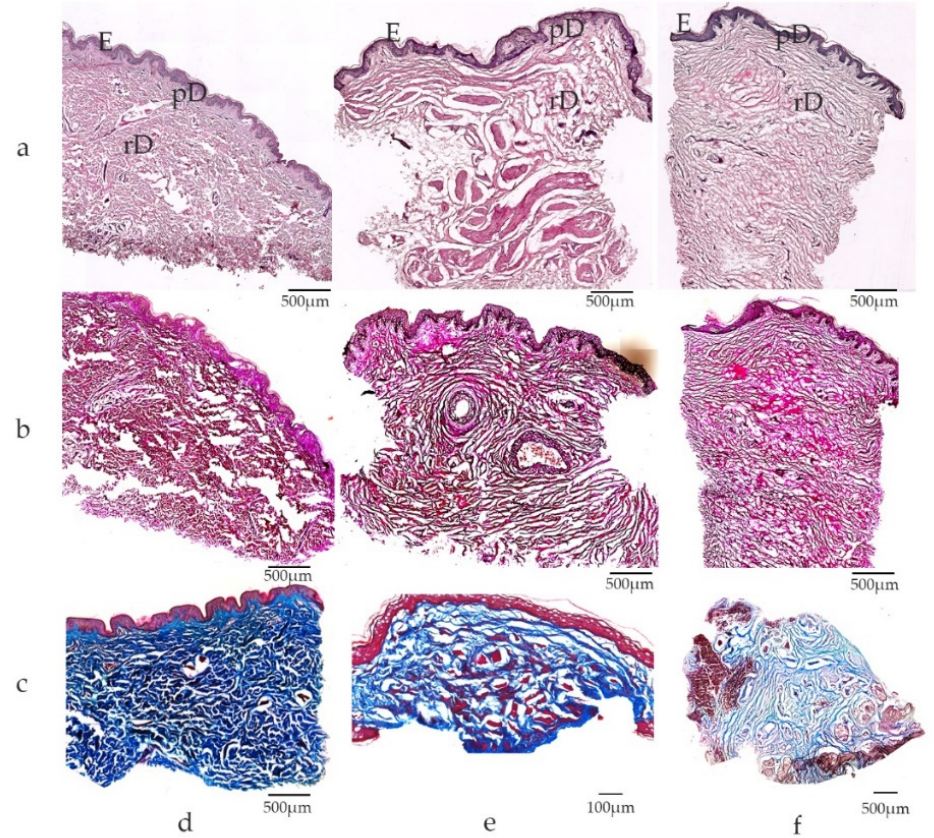
Figure 3. Microscopic view of extra-genital and genital skin specimens: ( a ) Hematoxylin-Eosin staining; ( b ) Elastica-van-Gieson staining; ( c ) Masson-Trichrome staining; skin samples from ( d ) extra-genital area (( a , b ): arm, c breast); ( e ) penis; ( f ) small labia. Note differences in dermal composition between extra-genital and genital skin, with dense dermal tissue in skin derived from the upper arm in contrast to lose connective tissue in genital skin. Elastic fibers are visualized by Elastica-van-Gieson staining with collagen in red and elastic fibers in black. Elastic fibers are abundant in genital skin with long, perpendicular arrangement of fibers in genital dermal tissue. ( c ) Dense connective tissue (blue) is found in extra-genital skin (breast) in contrast to loosely packed connective tissue in the dermis of the penis ( e ) and small labia ( f ). E epidermis, pD papillary dermis, rD reticular dermis; scale bars depicted for each panel.